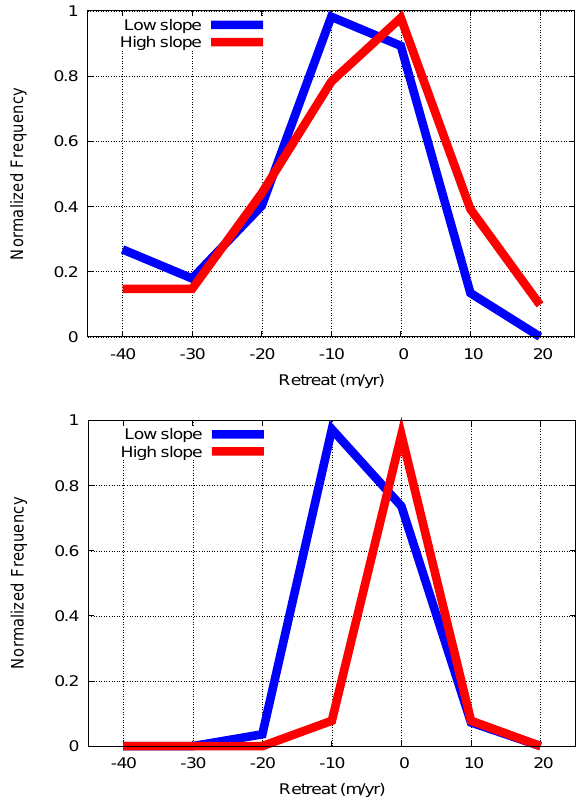
Fig. 14. Distribution of retreat rates. Top: from observed data of Scherler et al. (2011) and Bottom: for a simulated set of glaciers with low slope (0 . 14) and high slope (0 . 28). The bin size is 10.